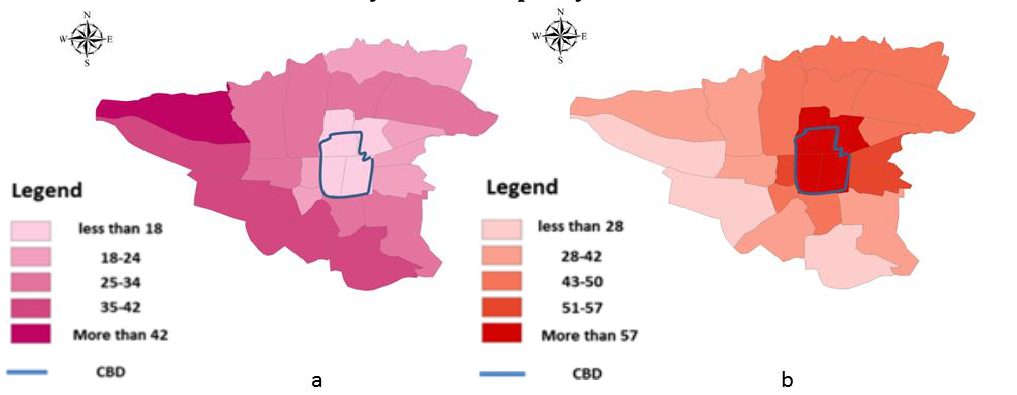
Figure 2: a) Average speed of vehicles in the street network, b) proportion of delay to total vehicle travel time by 22 municipality districts of